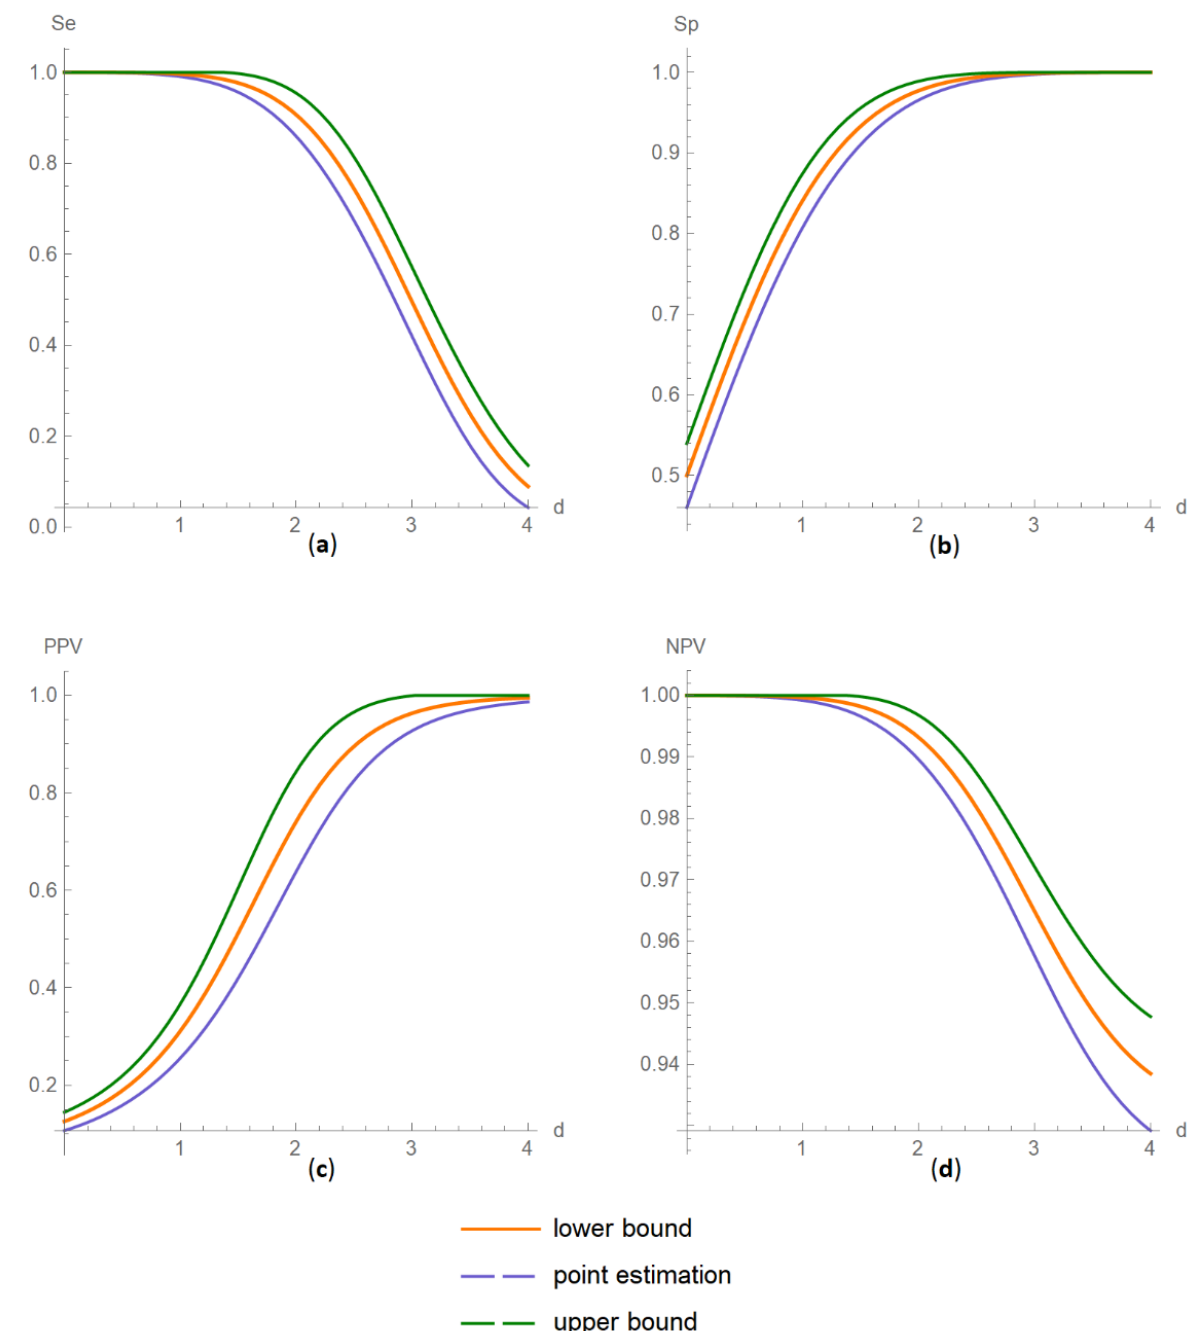
Figure 17. DAM relative standard uncertainties versus diagnostic threshold plots. Plots of relative standard combined, Figure 17. DAM confidence intervals versus diagnostic threshold plots. Plots of confidence intervals of ( a ) sensitivity ( Se ), measurement and sampling uncertainties of ( a ) sensitivity ( u ( Se )/ Se ), ( b ) specificity ( u ( Sp )/ Sp ), ( c ) positive predictive value ( b ) specificity (Sp), ( c ) positive predictive value ( PPV ) and ( d ) negative predictive value ( NPV ) versus diagnostic threshold ( u ( PPV )/ PPV ) and ( d ) negative predictive value ( u ( NPV )/ NPV ) versus diagnostic threshold ( d ) curves, with the respective ( d ) curves, with the respective parameter settings in Table 4. parameter settings in Table